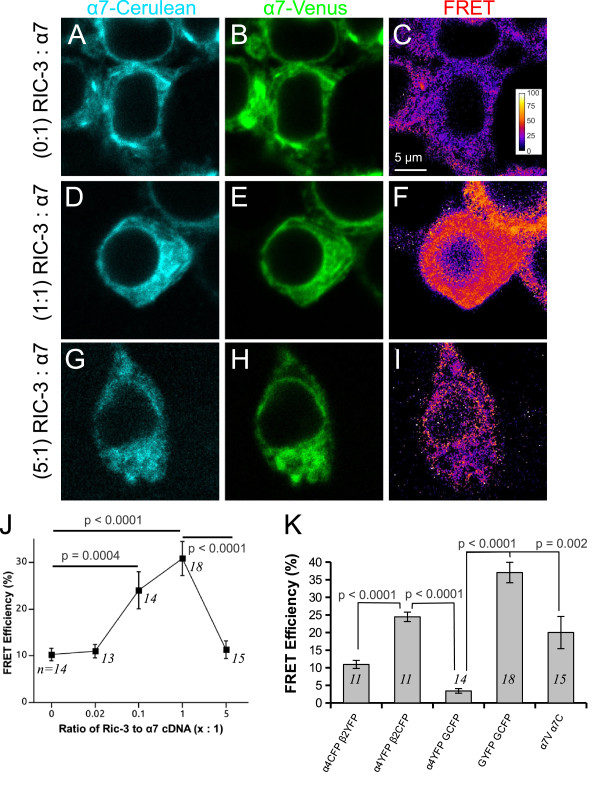
Changes in FRET efficiency between fluorescent α7 subunits upon co-transfection with RIC-3. Pixel based FRET was used to monitor assembly between α7-Venus and α7-Cerulean nAChR subunits. RIC-3 concentration was varied as molar ratio to total α7 plasmid: 0:1 (negative control), 0.02:1, 0.1:1, 1:1, and 5:1. Confocal images of transfected HEK293T cells showing α7-Cerulean (A, D, G), α7-Venus (B, E, H) and FRET efficiency (C, F, I) expression. FRET efficiency was higher in cells expressing RIC-3 at a 1:1 ratio to α7 (F) than cells not expressing RIC-3 (C) or cells expressing RIC-3 at a 5:1 ratio to α7 (I). (J) Summary plot showing that FRET efficiencies increased significantly (p < 0.0001, Kruskal-Wallis rank sum test) with increasing concentrations of RIC-3 relative to α7 but went to baseline at 5:1 ratio. There was a significant increase of FRET efficiency at 0.1:1 RIC-3 to α7 (p = 0.0004, Wilcoxon rank sum test) as compared to no RIC-3 cells and at 1:1 RIC-3 relative to α7 (p < 0.0001, Wilcoxon rank sum test). Numbers inside the plot represent the number of cells analyzed. (K) Control experiments validating the FRET measurements. α4YFP β2CFP shows significantly greater FRET efficiency than α4CFP β2YFP. This is expected because the transfection ratio favours an (α4)3(β2)2 stoichiometry [1] and the combination with the more acceptors (YFP) theoretically would have greater FRET efficiency. GYFP GCFP (GluClβ-YFP GluClα-CFP) are heteromeric glutamate-gated chloride channels found in invertebrates and show high FRET. Although they are members of the cys-loop family of receptors, they are not expected to assemble with any of the nicotinic receptors. Our negative control experiment, α4YFP GCFP (GluClα-CFP) shows very little FRET. A positive control experiment with RIC-3 and α7V α7C (α7-Venus α7-Cerulean) showing significant levels of FRET. Numbers inside the bars represent the number of cells analyzed.